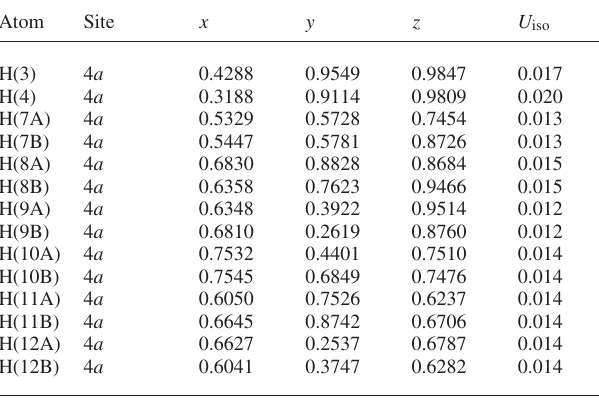
Table 2. Atomic coordinates and displacement parameters (in Å 2 )